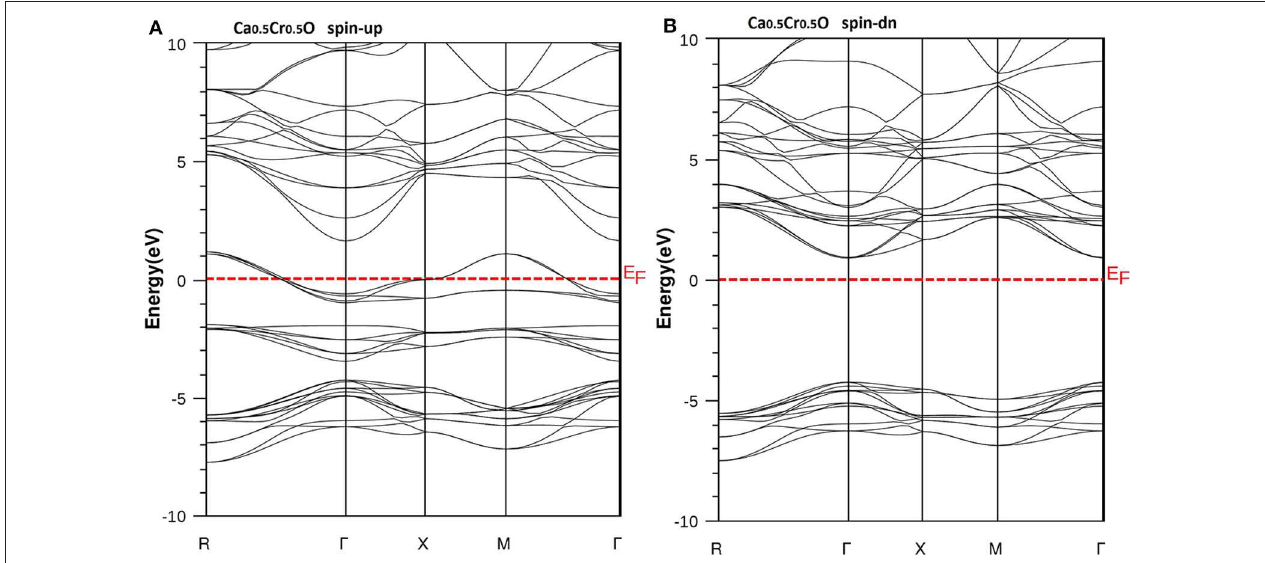
FIGURE 6 | Band structures of Ca 0.5 Cr 0.5 O. (A) Majority spins ( up ) and (B) minority spins ( dn ). The Fermi level is set to zero ( horizontal dotted line ).